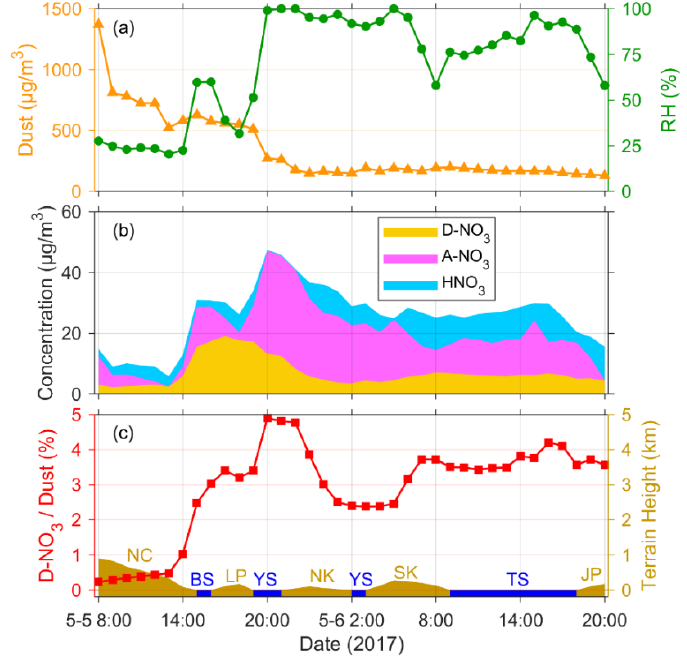
Figure 8. Variations of ( a ) dust concentration and RH; ( b ) D-NO 3 − , A-NO 3 − , and HNO 3 ; ( c ) the ratio of D-NO 3 − to dust concentration, the surface type (land and water), and terrain height along the 36-hour backward trajectory from Fukuoka, on May 6 2017, at 20:00 (JST), as shown if Figure 1. NC: North China, LP: Liaoning Peninsula, NK: North Korea, SK: South Korea, BS: the Bohai Sea, YS: Yellow Sea, TS: Tsushima